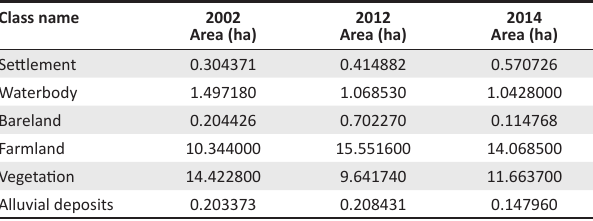
FIGURE 5: Flooded land cover and/or land use in Adamawa State in 2002. TABLE 1: Classified area of elements affected by flooding in